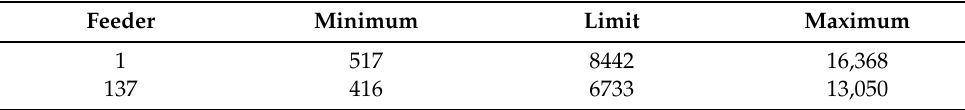
Table 5. EIDCU of the 136-bar